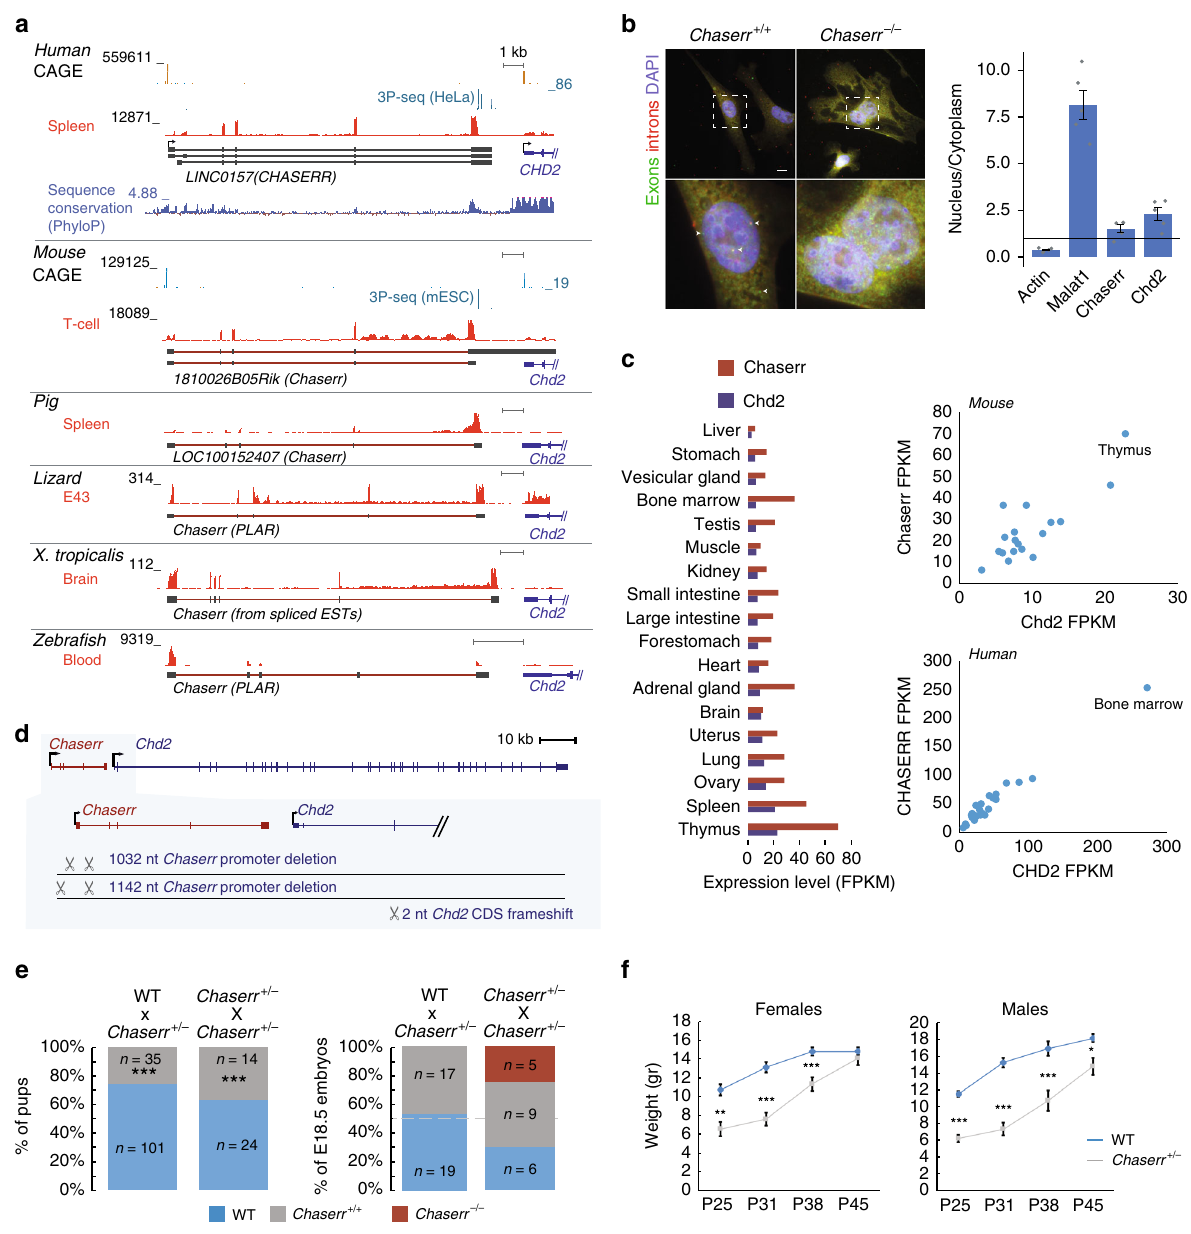
Fig. 1 Chaserr is essential for postnatal viability. a Genomic locus of Chaserr in the indicated vertebrate genomes. CAGE read coverage is from the FANTOM5 project 75 . 3P-seq data are from ref. 76 . RNA-seq data are from HPA 77 , ENCODE (mouse), FAANG (pig), SRP009831 (lizard), SRP039546 (xenopus), and SRP024369 (zebra fi sh). b Left: single-molecule FISH with probes targeting Chaserr introns (red) and exons (green) in mouse embryonic fi broblasts. Chaserr exons are marked by white arrowhead. Scale bar shows 10 µ m. Right: qRT-PCR comparing cytoplasm and nuclear fractions in mESCs. n = 5. c Left: Chaserr and Chd2 RNA expression across different tissues pro fi led in the mouse BodyMap 78 . Right: scatter plots for Chaserr and Chd2 expression in mouse BodyMap and human HPA 77 projects. d Schematic of the positions of regions targeted by gRNAs used to generate Chaserr − / − and Chd2 m/m mice. e Left: neonate survival rates for the indicated crossing. Right: embryonic survival rates at the indicated embryonic time points. f Weights of neonates at the indicated age (males n = 7 – 15, females n = 6 – 18 per group). Error bars show S.E.M. * P < 0.05, ** P < 0.01, and *** P < 0.001 ( e chi-squared test. f two-sided t test). Source data are provided as a Source Data fi le rarely became pregnant, and therefore we focused on crosses born from Chaserr + / – and Chaserr + / + crosses, 35 were between Chaserr + / + females and Chaserr + / – males for most of Chaserr + / – (~25%), signi fi cantly less than the expected 50% ( P < 10 − 5 , Fig. 1e), suggesting that two copies of Chaserr are required this study. Due to the close proximity and co-expression of Chaserr for proper postnatal survival. In contrast, embryos were recovered and Chd2 , we tested whether Chd2 expression is affected in with the expected Mendelian ratios in crosses between Chaserr + / – Chaserr + / – embryos. Chd2 mRNA was signi fi cantly upregulated and Chaserr + / + mice and in Chaserr + / – intercrosses (Fig. 1e and Supplementary Fig. 1l), suggesting that Chaserr is required for by ~1.5-fold during embryonic development at the examined postnatal, but not embryonic, survival. Chaserr + / – females very time points (E9.5, E10.5, and E13.5), in mEFs derived from E13.5 NATURE COMMUNICATIONS| (2019) 10:5092